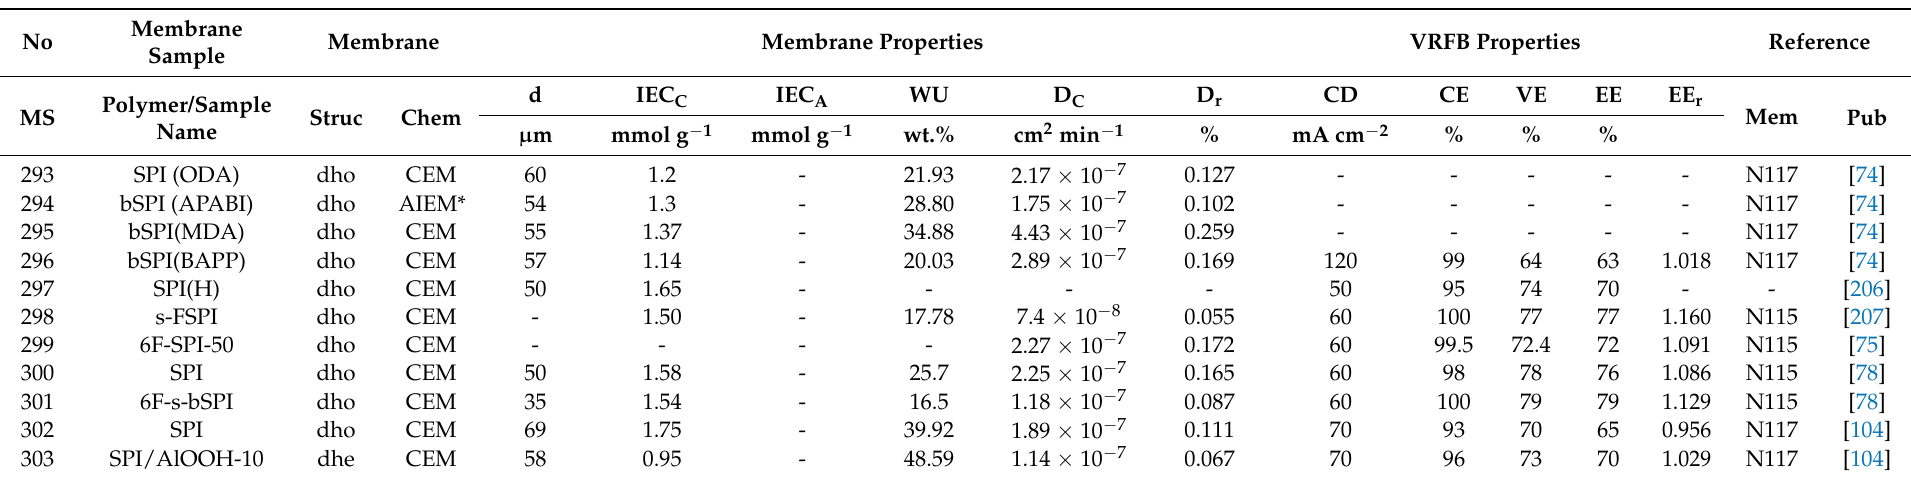
Table 14. List of poly(phthalazinone ether)-based N -heterocycle membrane